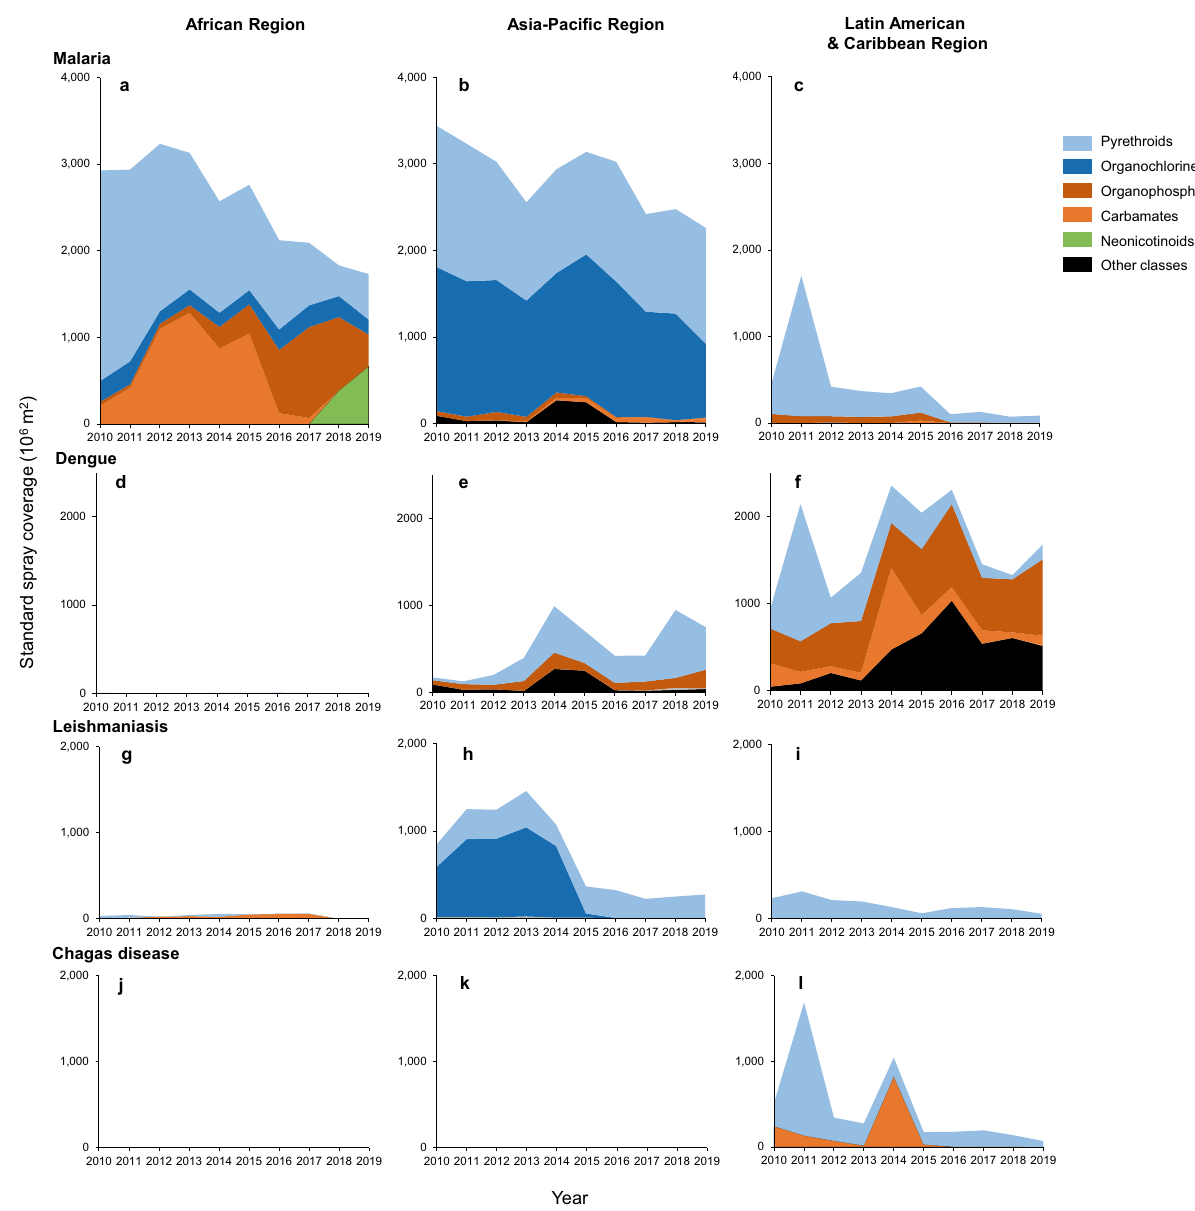
Figure 4. Area graph of vector control insecticide use, excluding use in ITNs, by disease. Results are presented for three geopolitical regions, ( a – c ) for control of malaria, ( d – f ) dengue, ( g – i ) leishmaniasis, and ( j – l ) Chagas disease, and expressed in standard spray coverage. Shades of blue or shades of red indicate insecticide sub- groups within a mode of action 21 . ‘Other classes’ represent bacterial larvicides, insect growth regulators and spinosyns (all used as